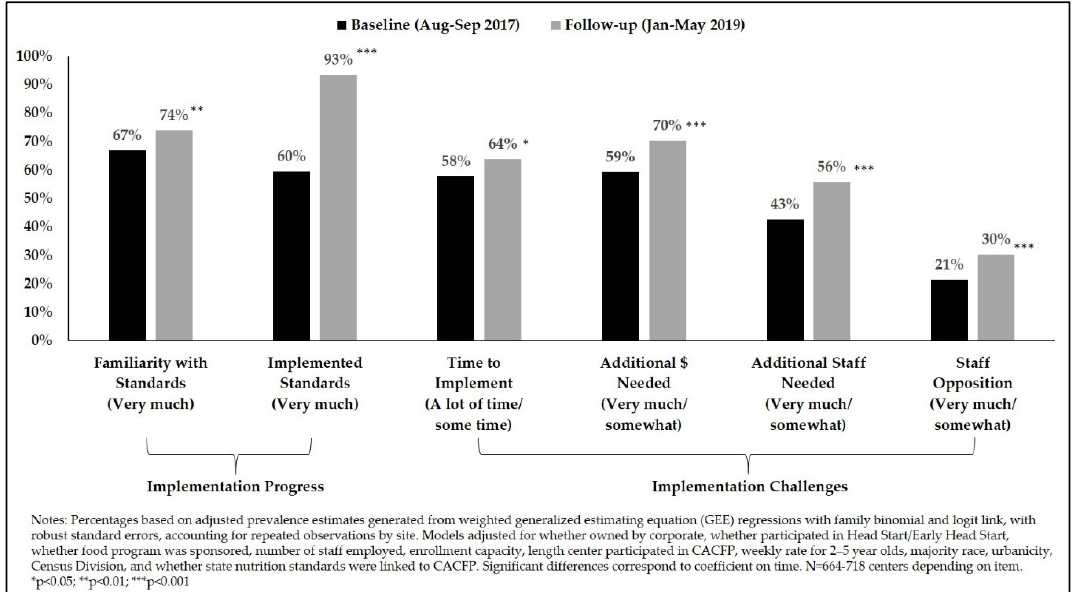
Figure 1. Progress and challenges in implementing updated CACFP meal pattern standards, 2017–2019.